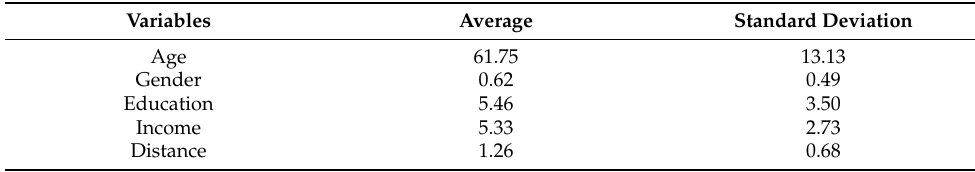
Table 3. Individual and family characteristics of the interviewed farmers.